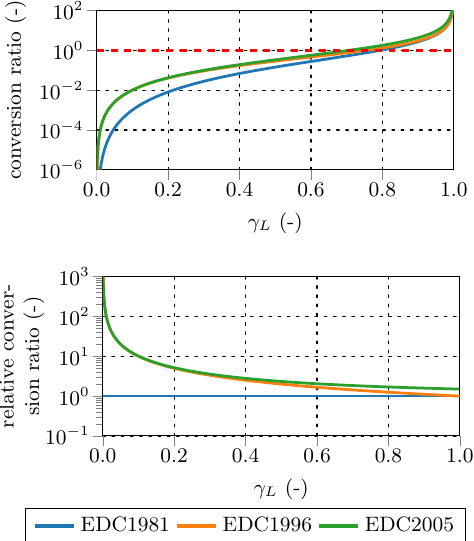
Figure 2. Comparison of the proposed EDC reaction rate conversion factors; dashed line represents limit according to Equation (19).